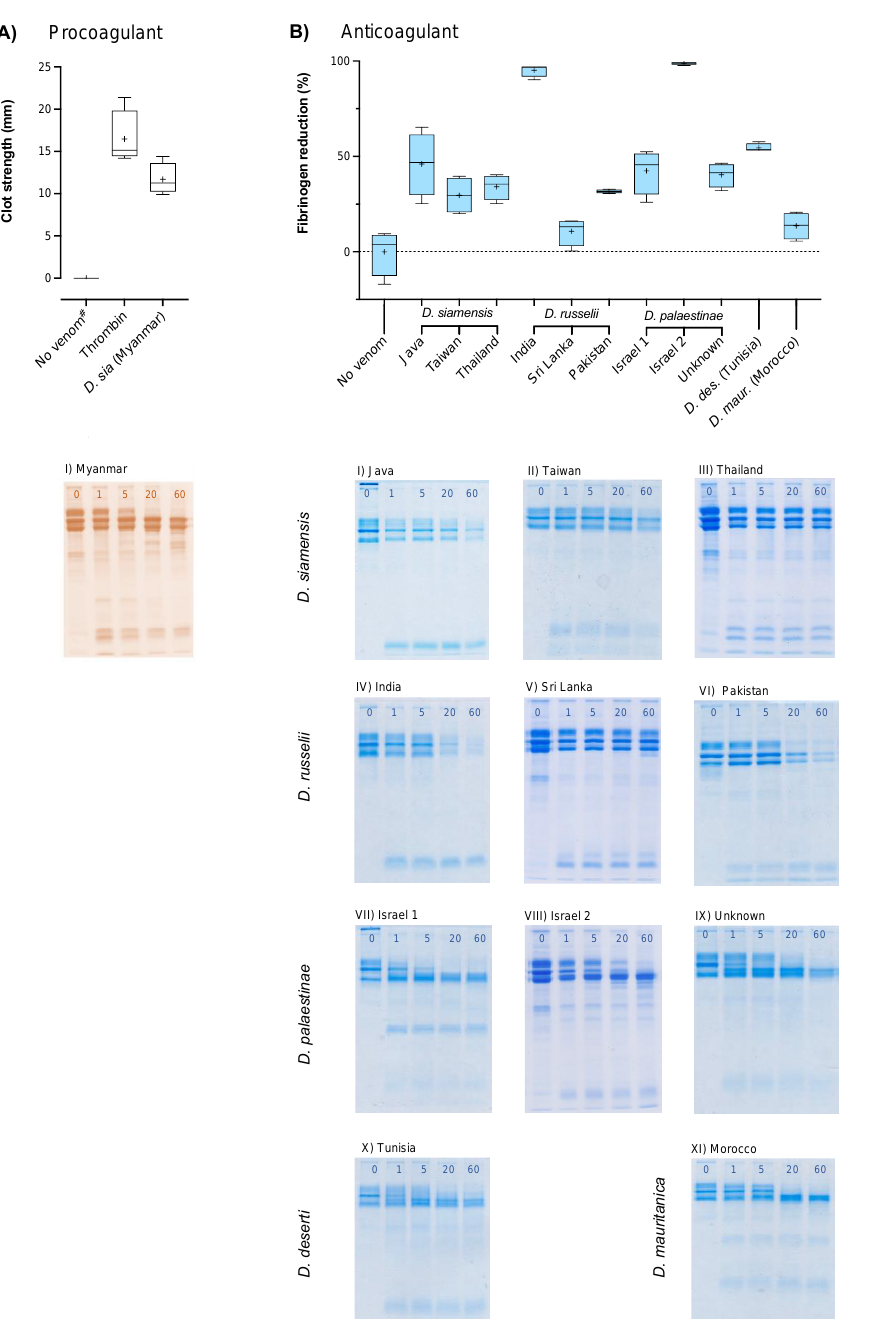
Figure 7. Procoagulant (column A ) and anticoagulant (column B ) activities of twelve Daboia venoms on human fibrinogen over time measured by thromboelastography (0.1 mg venom per 10 mg fibrinogen per final mL) ( top row ) and fibrinogen gels (0.1 mg/1 mg/mL) ( bottom row ), incubated at 37 ◦ C for up to 60 min. Thromboelastography conditions were: fibrinogen and venom (procoagulant test conditions), fibrinogen and thrombin (procoag. pos. cont.), and fibrinogen and vehicle solution (procoag. neg. cont.) combined and measured for 30 min (figure A ), after which thrombin was added to any samples that had not formed clots so that: [fib. and venom for 30 min] + thrombin (anticoag. test cond.), and [fib. + vehicle for 30 min] + thrombin (anticoag. neg. cont.) combined and measured for 30 additional min (figure B ). Box plots depict median (line), mean (+), and range (error bars) of four independent replicates of: ( A ) Clot sizes by venoms that stimulated clotting in the procoagulant test conditions, # = no spontaneous clotting occurred; and ( B ) Reduction in functional fibrinogen (%) by all other venoms assessed in the anticoagulant test conditions, normalised between the anticoagulant negative control clot size (0% reduction) and zero (100% reduction). Fibrinogen gel images are one representative from three independent replicates; lane 1 = no venom and 0 min incubation, lanes 2–5 = 1, 5, 20, 60 min incubation; panels AI-BIII = D. siamensis , BIV-VI = D. russelii , BVII-IX = D. palaestinae , BX = D. deserti , BXI = D. mauritanica